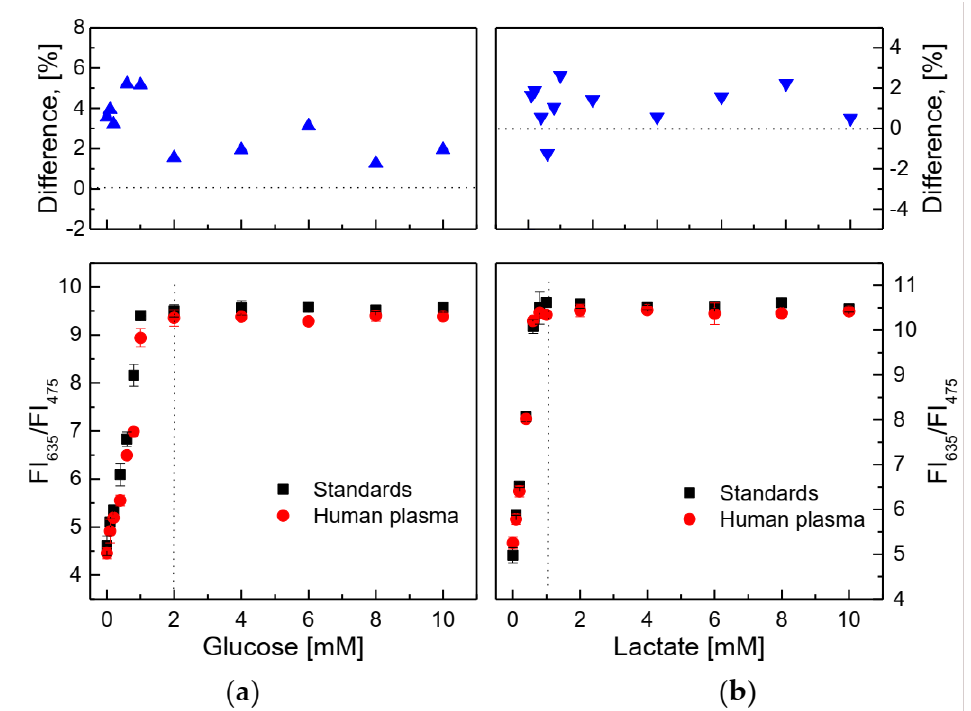
Figure 12. ( a ) Response of the glucose-sensing membrane to solutions of standard glucose and artificial human plasma glucose, and ( b ) response of the lactate-sensing membrane to solutions of standard lactate and artificial human plasma lactate. Percent difference of ratiometric fluores- cence intensities (R = FI 635 /FI 475 ) in glucose (or lactate) concentrations between standard solu- tion and artificial human plasma represents 100 × {(R std glucose -R human plasma glucose )/R std glucose } or 100 × {(R std lactate -R human plasma lactate )/R std lactate